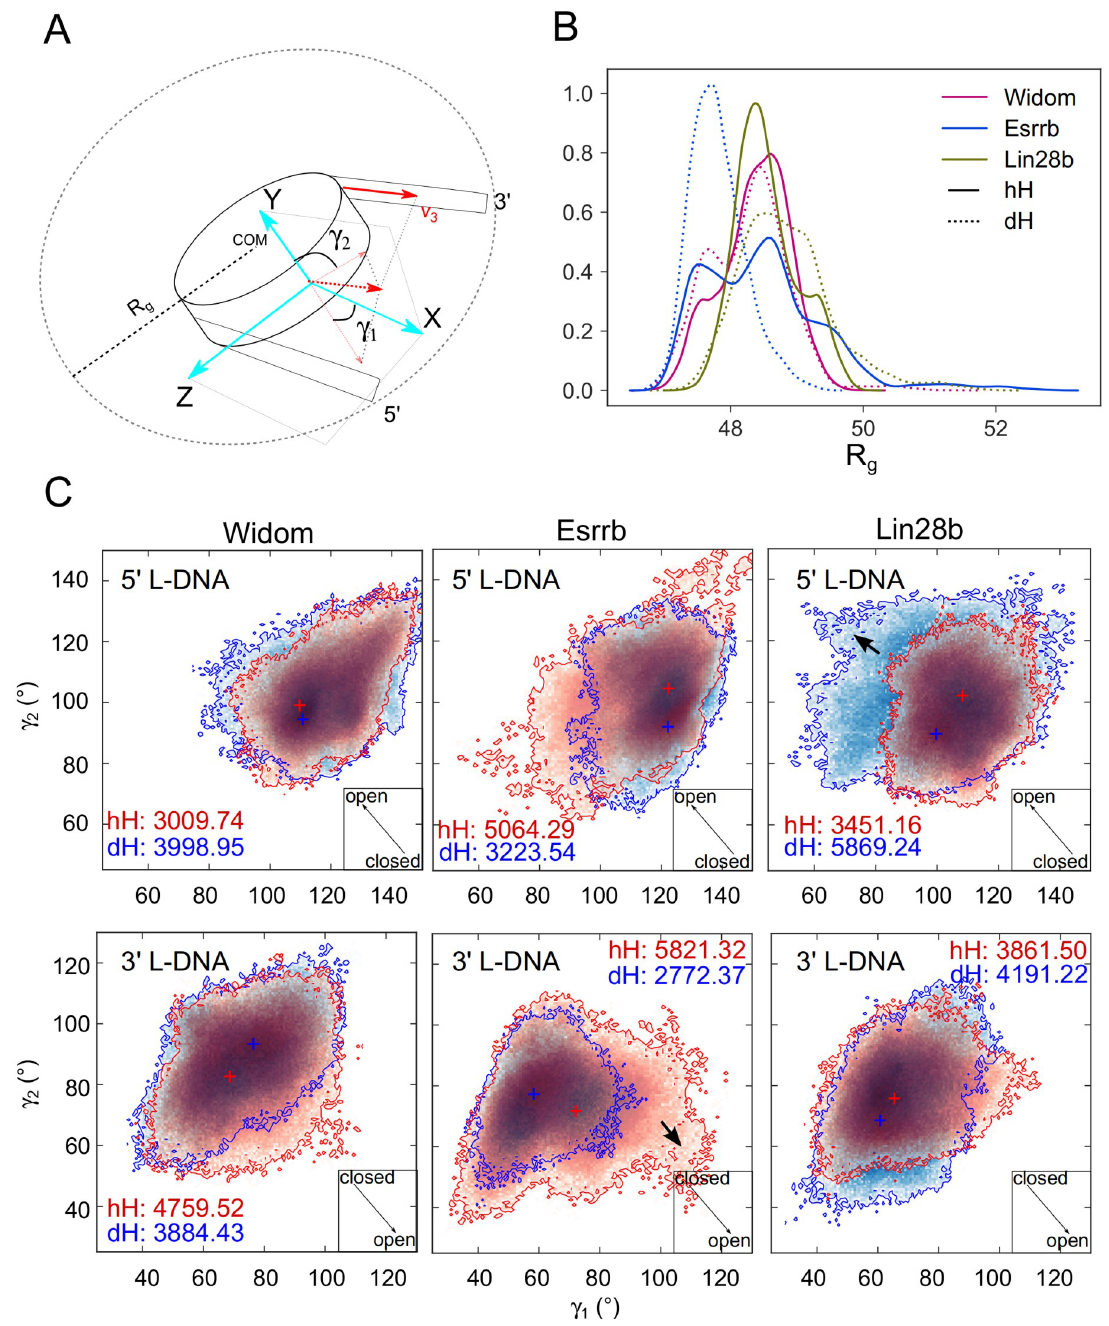
Fig 2. Nucleosome structural flexibility. (A) Schematic representation of the R g definition and the coordinate system used to describe nucleosome conformations. The angles γ 1 and γ 2 , describing the nucleosome breathing motions were defined as described in Methods. An increase of γ 1 indicates opening at the 3’ L-DNA, but closing at the 5’ L-DNA, and vice-versa for γ 2 . (B) R g distribution from the 3 μ s ensembles of simulations. Larger values indicate a lower degree of compaction in the nucleosomal DNA. Solid and dashed lines represent the hH and dH simulations, respectively. The Widom, Esrrb, and Lin28b nucleosomes are shown in magenta, blue and green respectively. (C) Two-dimensional histograms depicting the conformational sampling of the 5’ and 3’ L-DNA arms in the space defined by the γ 1 and γ 2 angles. The arrow inserts in the lower-right corner indicate the direction of the opening, whereas the numbers are the areas of the histograms. The crosses indicate the most populated region of each histogram. The data for the hH and dH nucleosomes are in red and blue respectively. The two bolded arrows indicate the two extensive openings (complete data in S1